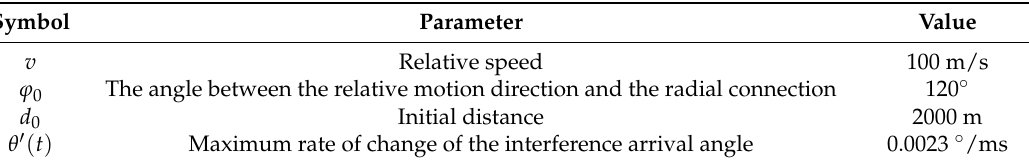
Table 2. Dynamic parameter setting.